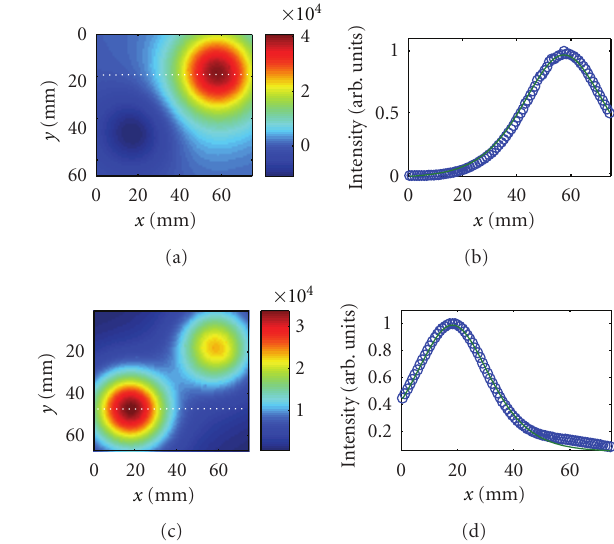
Figure 8: PCIDs on the detector plane are shown in (a) and (c); and corresponding Green’s function fits to the horizontal spatial profiles through the dashed line are shown in (b) and (d).